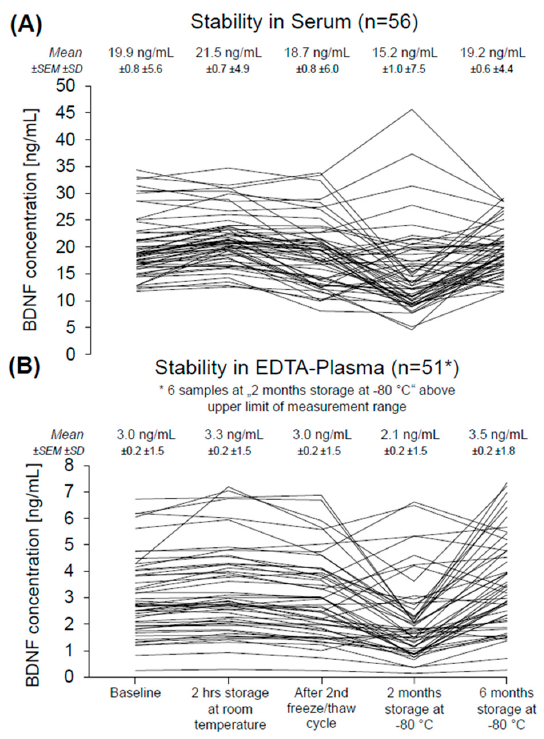
Figure B2. Individual changes in serum ( A) and EDTA-plasma ( B ) BDNF from “Baseline” (T1) to “6 months storage at − 80 °C” (T5). BDNF: brain-derived neurotrophic factor, EDTA: ethylenediaminetetraacetic acid, hrs: hours.